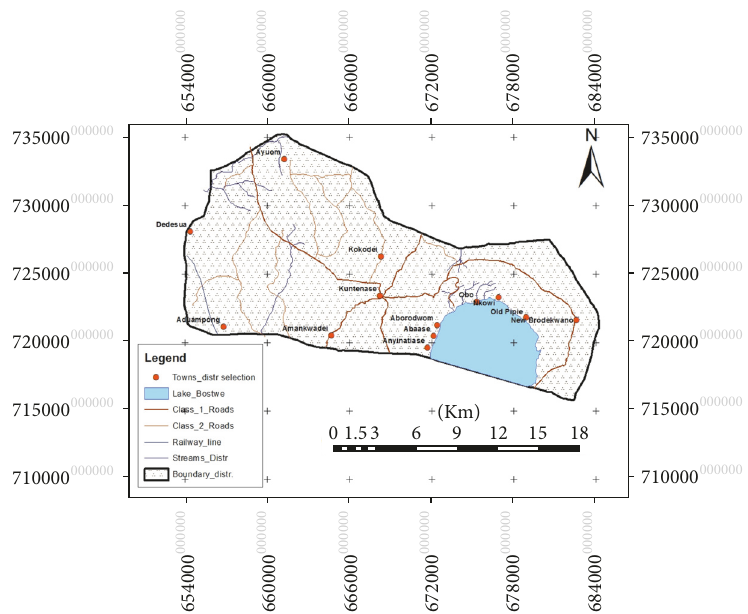
Figure 1: Map of the Bosomtwe District in Ghana. Source: author’s construct